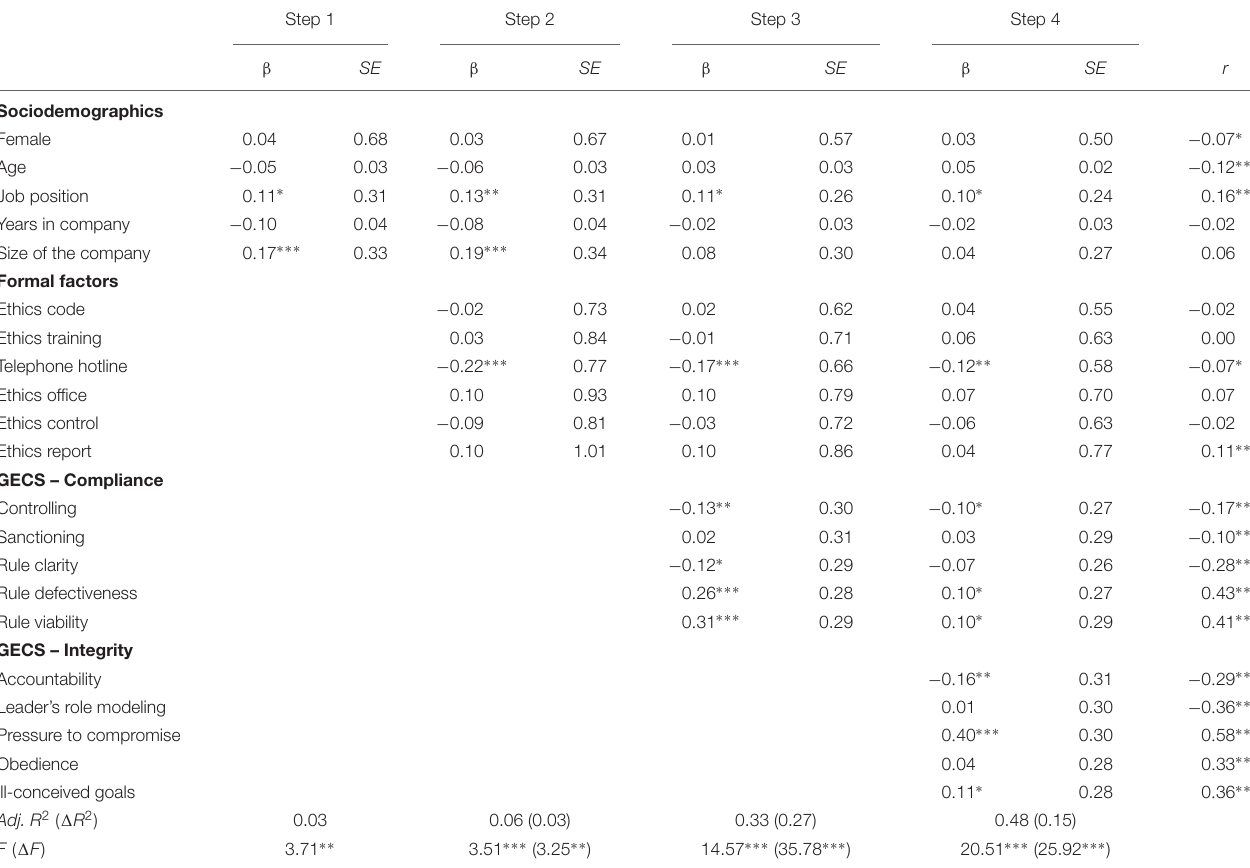
TABLE 6 | Results on hierarchical regressions and correlations with deviant workplace behavior (Sample B, Study